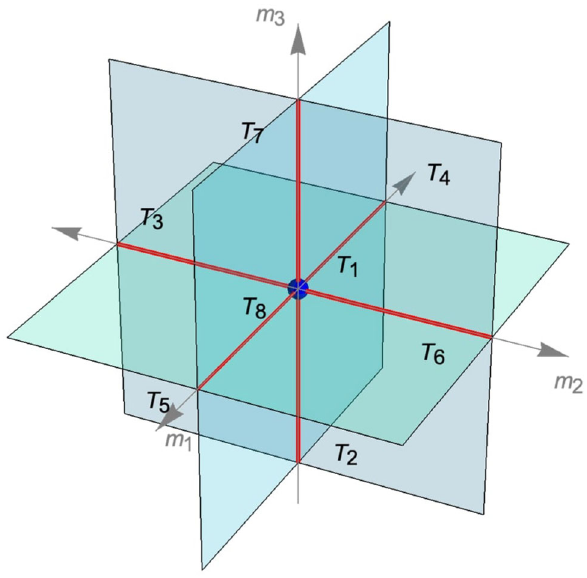
Fig. 5 The three-dimensional phase diagram of SU ( N ) k + p ψ 1 + q ψ 2 + ( F − p − q )ψ 3 with k ≥ F / 2. The blue ball represents the critical point, the red lines are the critical lines given by Eq. (10) while the planes in cyan are the critical planes, each plane is described by one of the critical theories in Eq.